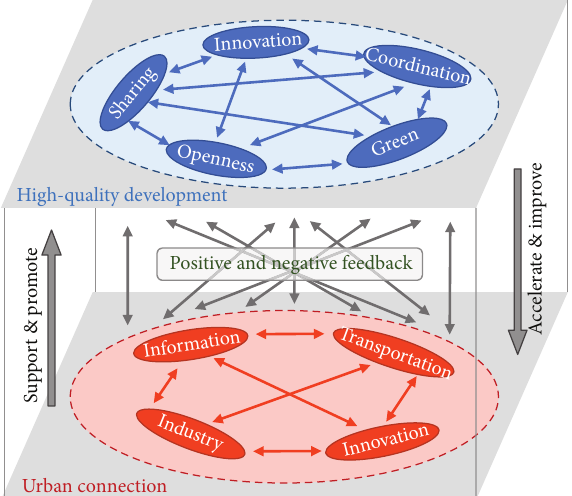
Figure 1: Relationship between urban connection and high-quality